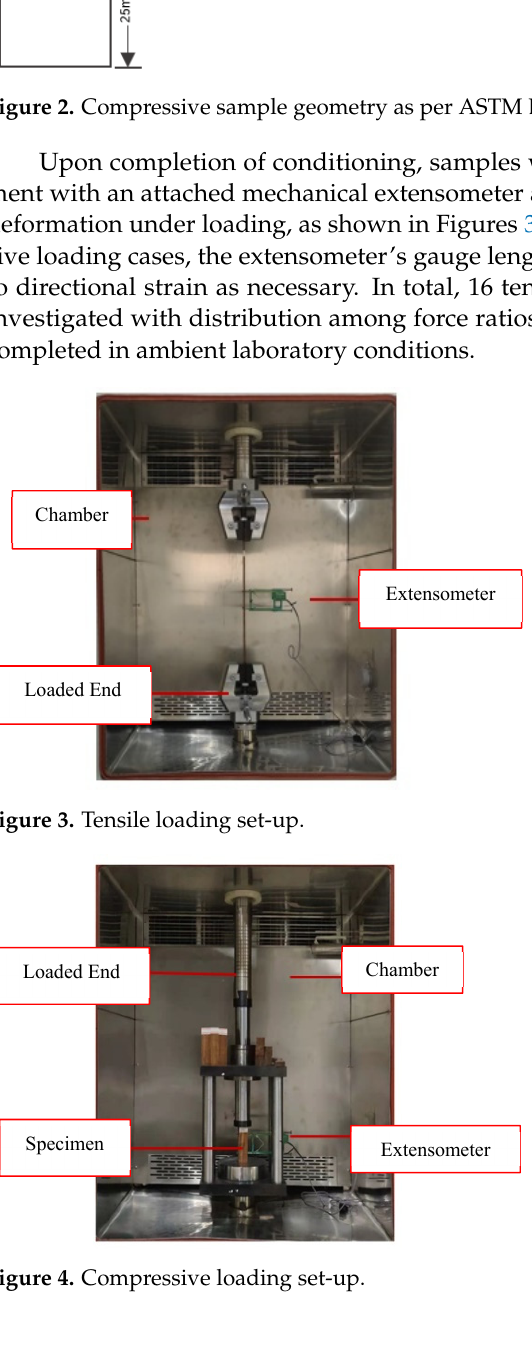
Figure 2. Compressive sample geometry as per ASTM D143 (mm).